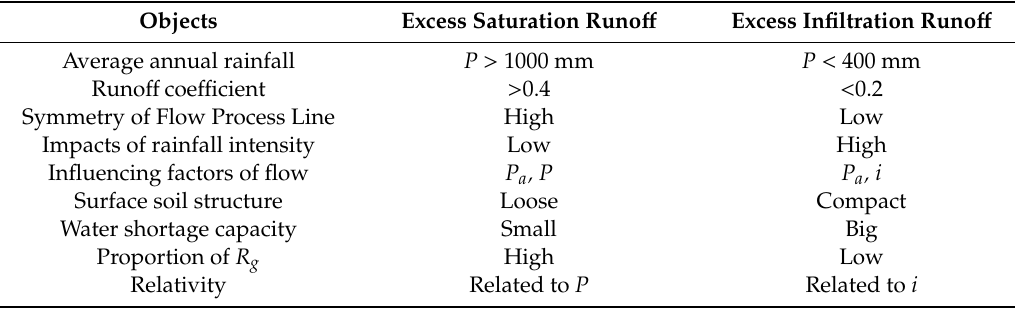
Table 3. Comprehensive analysis table of runo ff generation